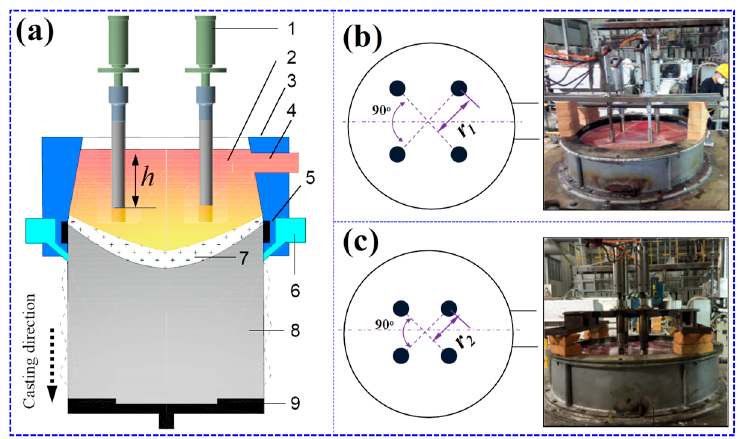
Figure 1. ( a ) Schematic showing configuration of the multiple ultrasonic-generators in the direct chill